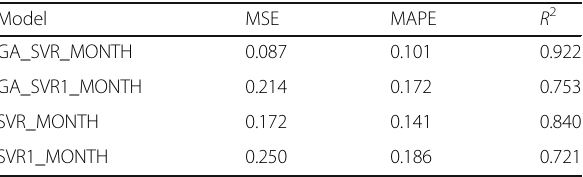
Table 1 Comparison of the prediction accuracy of the monthly BD incidence prediction